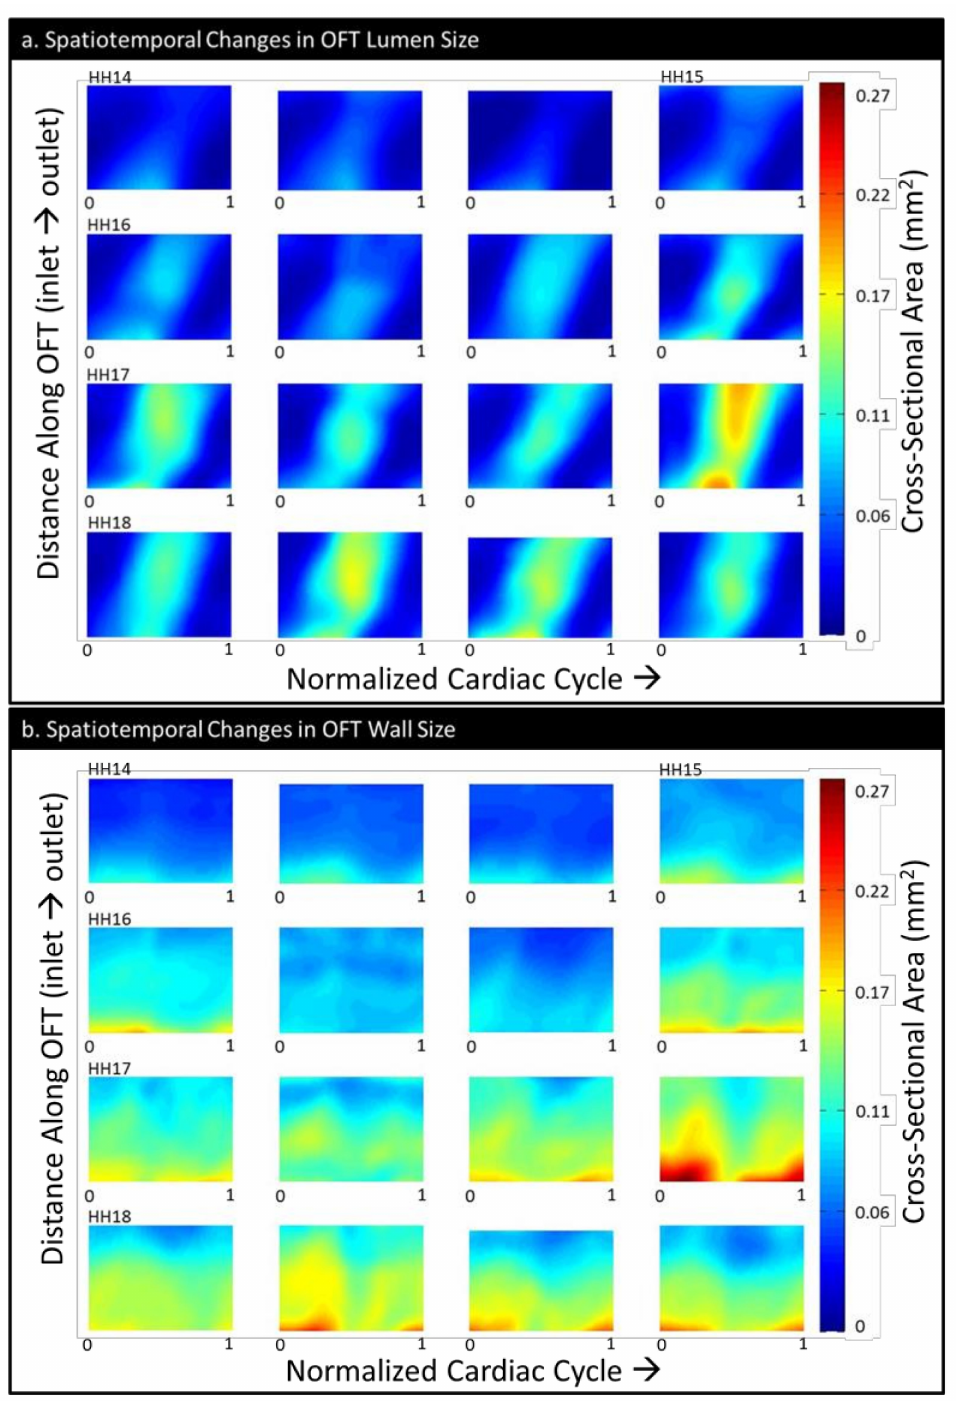
Figure 5. The OFT size depicted as the color-coded area of its cross sections over time (normalized cardiac cycle, horizontal axis) and space (normalized OFT length, inlet to outlet, vertical axis): ( a ) the spatiotemporal changes in the OFT lumen cross-sectional area and ( b ) the spatiotemporal changes in the OFT wall (cushions plus myocardium) cross-sectional area. The embryos have been ordered from youngest to oldest within each stage group and aligned in rows by